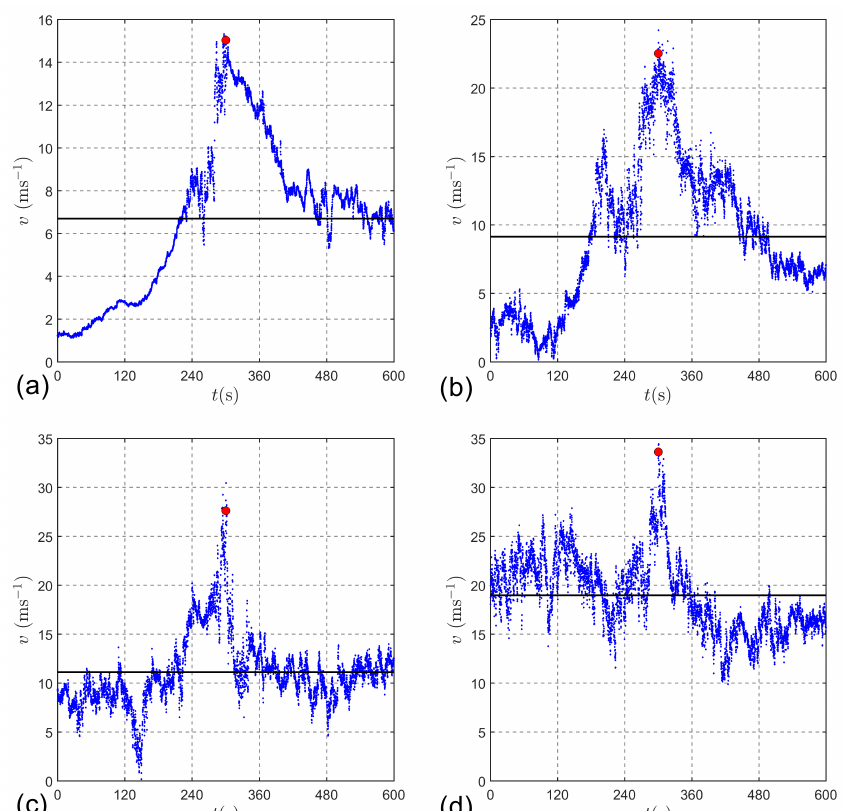
Figure 11. Thunderstorm outflow records characterized by different wind speed classes (a) recorded on 25 August 2015 at 03:20UTC by the anemometer 1 of the port of Livorno; (b) 15 October 2012 at 00:20UTC by the anemometer 3 of the port of La Spezia; (c) 16 November 2010 at 02:00UTC by the anemometer 5 of the port of Livorno; and (d) 16 December 2011 at 22:50UTC by the anemometer 1 of the port of